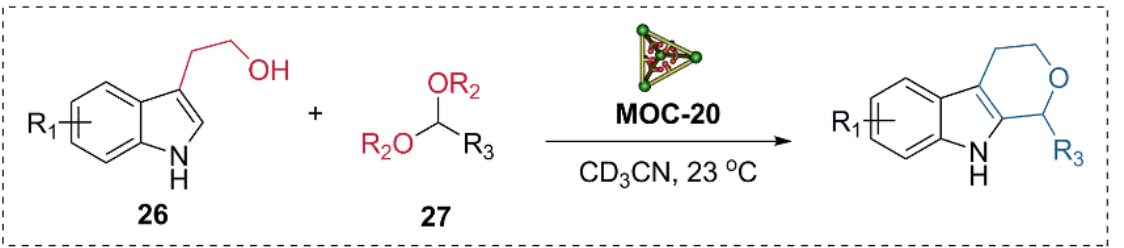
Figure 21. Pictet - Spengler cyclization of tryptophol and serials of benzaldehyde dimethyl acetal Figure 21. Pictet-Spengler cyclization of tryptophol and serials of benzaldehyde dimethyl acetal catalyzed MOC-20 [95]. Reaction conditions: 26 (15.8 mM), 27 (19.8 mM), MOC-20 (5 mol%), CD 3 CN, catalyzed MOC -20 [95]. Reaction conditions: 26 (15.8 mM), 27 (19.8 mM), MOC-20 (5 mol%), 23 ◦ C. Reprinted/adapted with permission from Ref. [95]. Copyright 2020 Wiley CD 3 CN, 23 °C. Reprinted/adapted with permission from Ref. [95]. Copyright 2020 Wiley VCH.